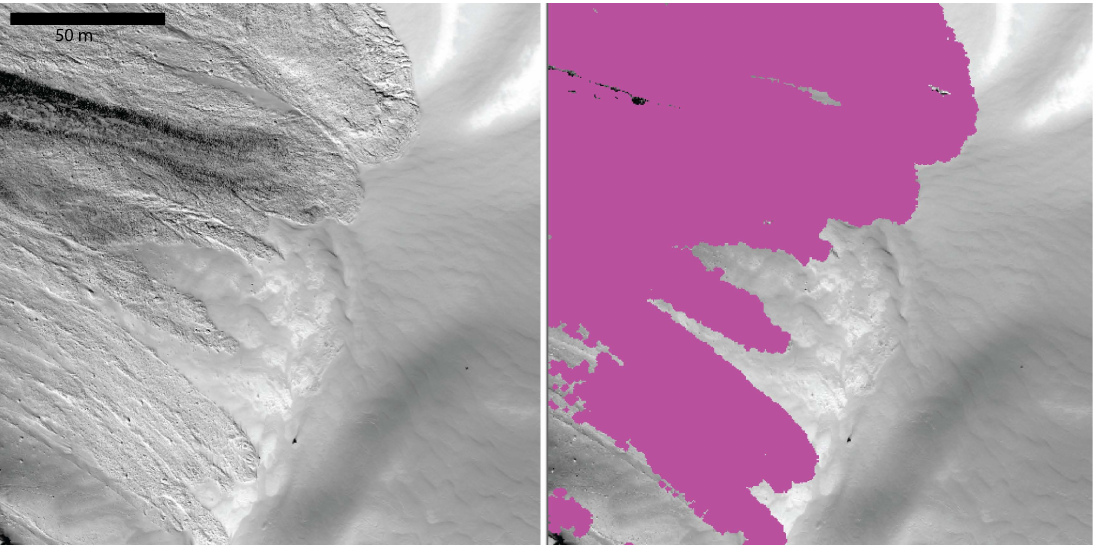
Fig. 11. Raw image ( a , left) overlain by automatically identified avalanches ( b , right) for a simple scene that does not contain noise or regions characterised by large tonal changes.